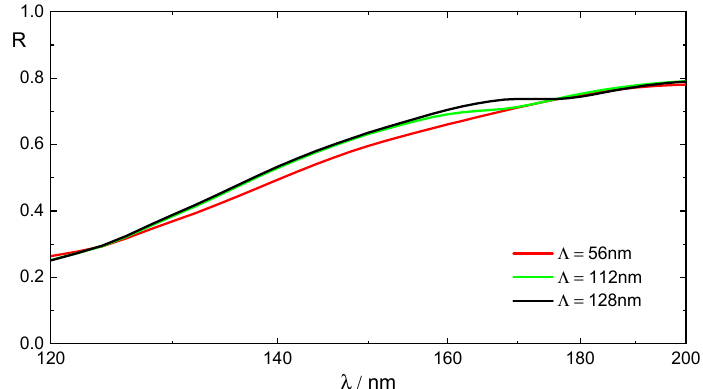
Figure 7. Calculated VUV reflectance of unprotected aluminum films with σ = 2 nm, and different periods Λ .